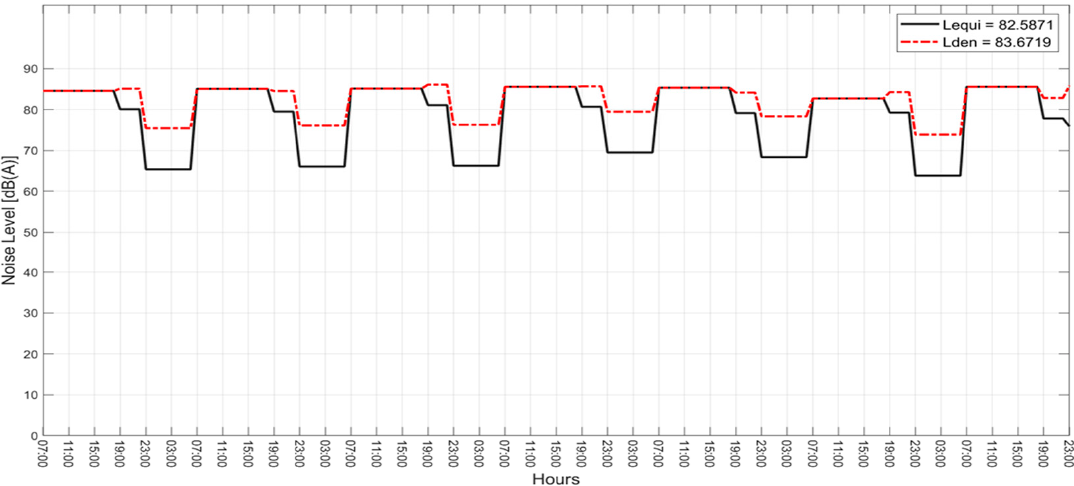
Figure 7. The equivalent noise level (L eq ) per hour measured and the day-evening-night noise level (L den ) in the GH ICU.